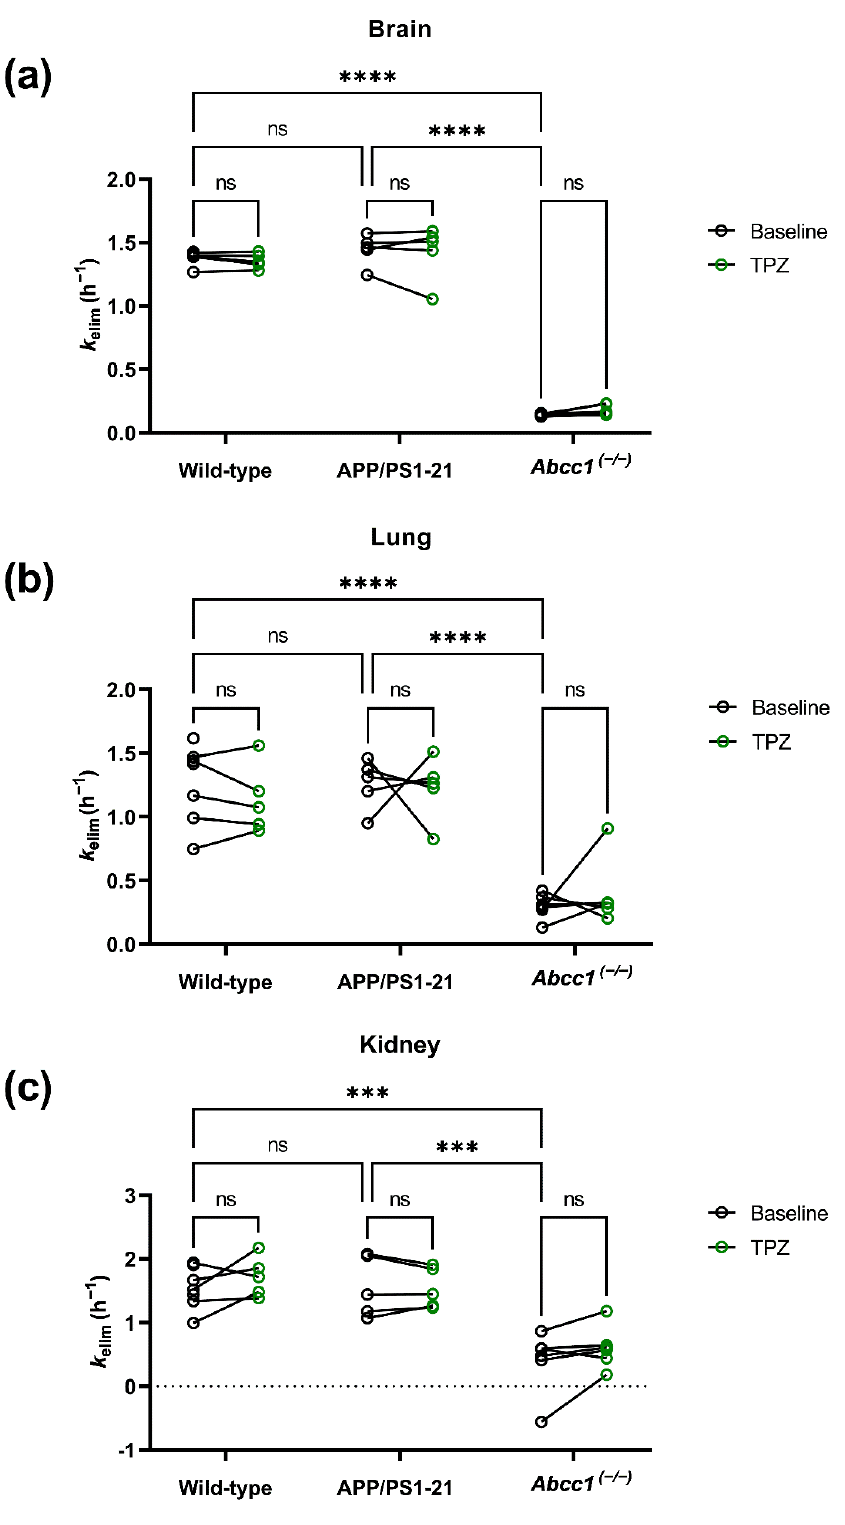
Figure 3. Elimination rate constants of radioactivity ( k elim ) from the brain ( a ), the right lung ( b ) and the left kidney ( c ) in wild ‐ type, APP/PS1 ‐ 21 and Abcc1 ( − / − ) mice at baseline and following 5 ‐ day oral treatment with thiethylperazine (TPZ, 15 mg/kg, once daily). ns, not significant, *** p ≤ 0.001, **** p ≤ 0.0001, two ‐ way ANOVA followed by a Šidák’s multiple comparisons test.